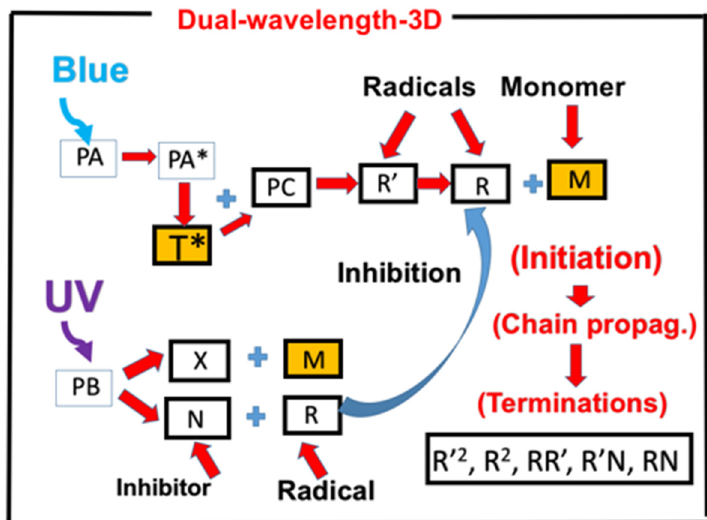
Figure 1. Schematics of photochemical pathways of dual wavelength photopolymerization; in which crosslinkers are formed via two pathways, via the photoinitiator PA (under a blue light), and PB (under a UV light). The initiation radicals R and [X] crosslink with the monomer [M]; whereas the inhibition radicals [N] reduces the conversion efficacy by reducing the active radicals (R’ and R). Shown also is the co-initiator (PC), which reacts with the triplet state of PA (T*) forming an intermediate radical (R’). Bimolecular termination of R’ produces a propagating radical (R) which leads to crosslinks; terminations could be also resulted by the interaction of R and R’, and R and [N].